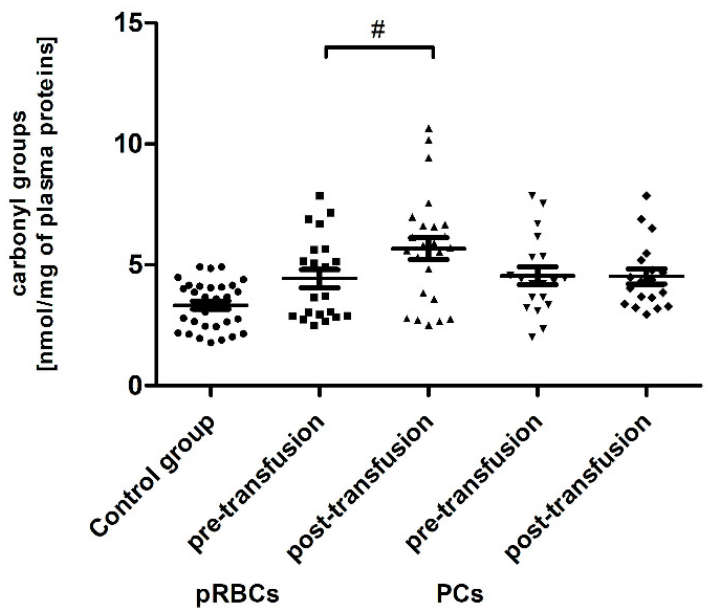
Figure 2. The carbonyl group content in plasma proteins in healthy volunteers (control group) and AML patients before and after transfusion of the blood component. Scatter plots show all of the data values obtained. Data are presented as mean ± SE. # p < 0.05 compared post- versus pre-transfusion; statistically significant according to the Tukey test. pRBCs—packed red blood cells; PCs—platelet concentrates.